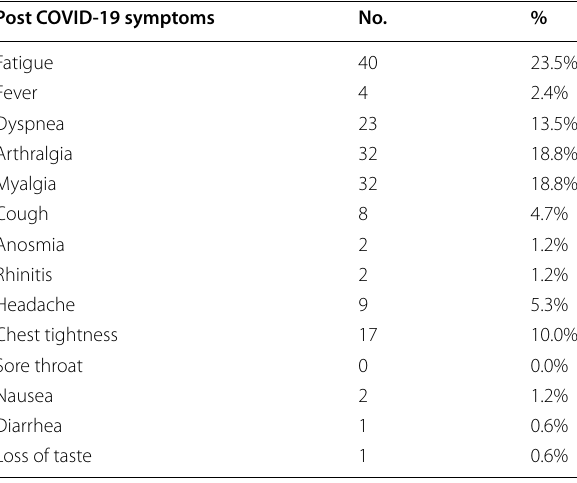
Table 2 Descriptive of post COVID-19 clinical characteristics Post COVID‑19